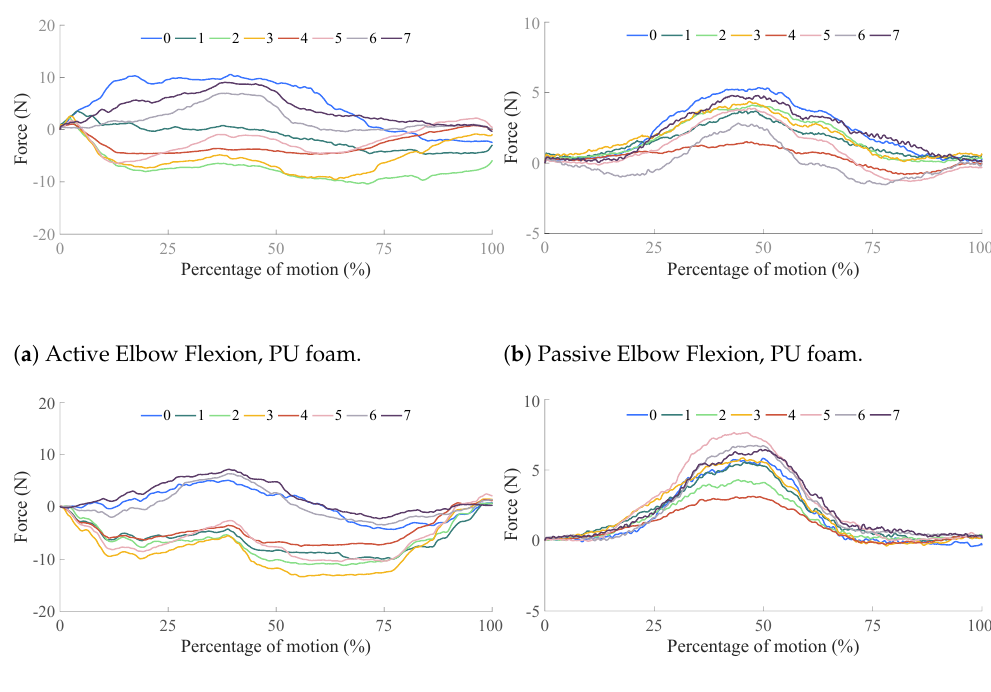
Figure 12. Results from the elbow flexion–extension movements performed by the subject while wearing the Harmony exoskeleton. Active movements refer to the subject performing the elbow flexion–extension while the robot follows in the gravity-compensation mode (accounting only for the robot’s own weight). Passive movements refer to the robot performing the movement while the subject follows passively. The elbow is fully extended at the beginning and end of each plot and fully flexed in the middle. The two foams—PU and blended EPDM—are shown in Figure 13.